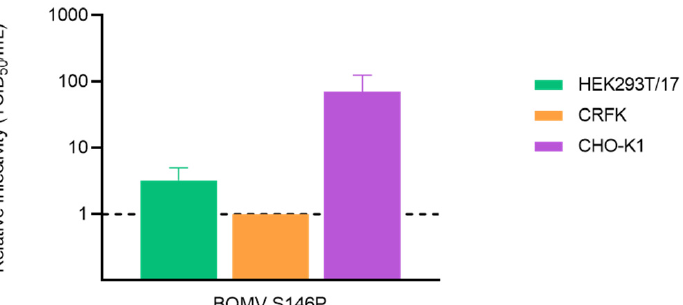
Figure 3. Analysis of NPC1 receptor binding to the ebolavirus glycoprotein. ( a ) The structure of human NPC1 receptor (blue) in complex with the EBOV glycoprotein (white) which highlights three NPC1-interacting regions (red) covering glycoprotein amino acids 79–88, 111–118 and 141–152. Alignment of the interface of ( b ) NPC1 sequence from HEK293T/17 ( Homo sapiens ), CRFK ( Felis catus ) and CHO-K1 ( Cricetulus griseus ) cell lines and ( c ) ebolavirus glycoprotein sequences, with residues in direct contact highlighted in squared boxes. Virus-specific polymorphisms are shaded yellow and red for amino acids similar or dissimilar to the consensus, respectively. The BOMV glycoprotein proline (P) to serine (S) polymor- phism (P146S) is outlined. Figure 4. Restored infectivity of BOMV lentiviral-pseudotyped virus into CHO-K1 target cells after reversion of a serine at position 146 of the glycoprotein to a conserved proline (S146P). Infectivity, measured as TCID 50 /mL, calculated relative to a pseudotyped virus incorporating the wild type